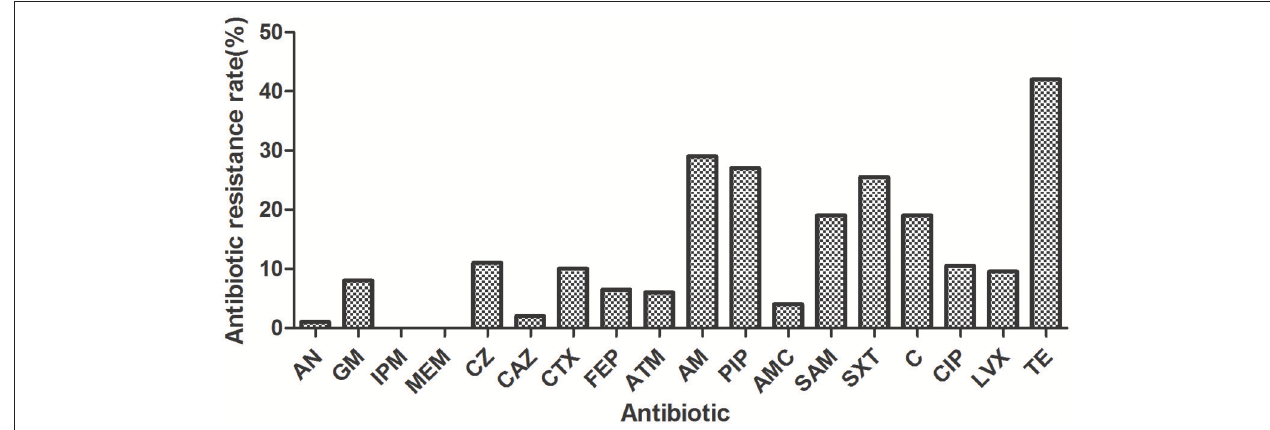
FIGURE 2 | Antibiotic resistance rates of the E. coli isolated from drinking water sources (the Qiantang River and the Dongtiao Stream). AN, amikacin; GM: gentamicin; IPM, imipenem; MEM, meropenem; CZ, cefazolin; CAZ, ceftazidime; CTX, cefotaxime; FEP, cefepime; ATM, aztreonam; AMP, ampicillin; PIP, piperacillin; AMC, amoxicillin/clavulanate; SAM, ampicillin/sulbactam; C, chloramphenicol; CIP, ciprofloxacin; LVX, levofloxacin; TE, tetracycline.